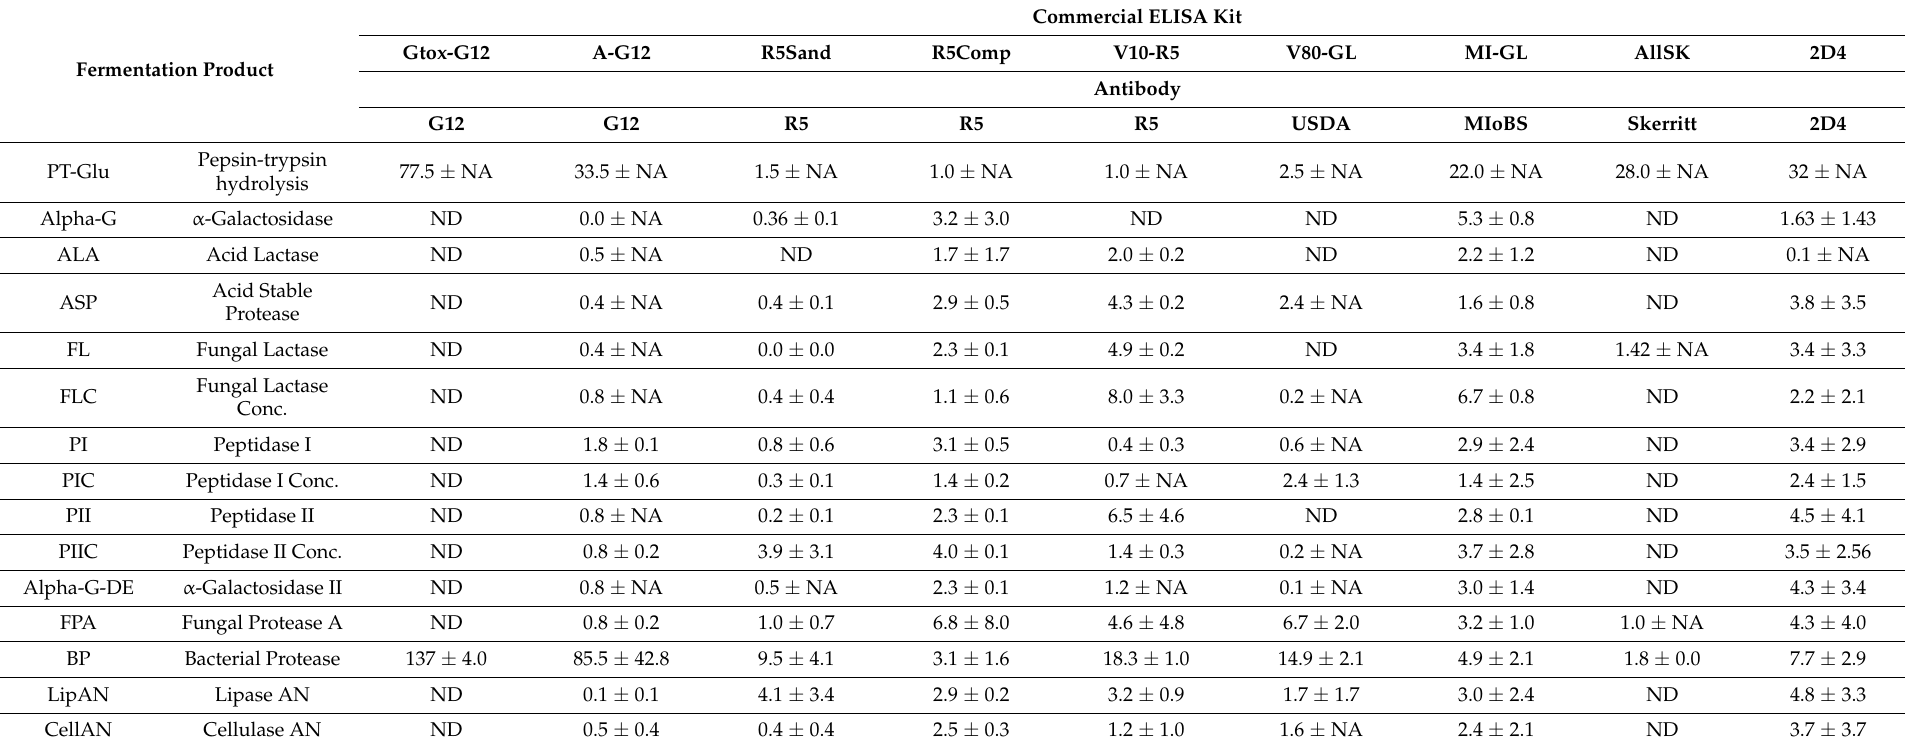
Table 3. Gluten levels for the supplemental enzyme samples were negligible or lower than the PT-digested gluten sample (N = 6). The multiplex ELISAs using antibodies from commercially available kits specific for gluten detection were used to detect gluten levels in supplemental enzyme preparations. ND = non-detectable. NA = not available, as only one replicate was above the limit of